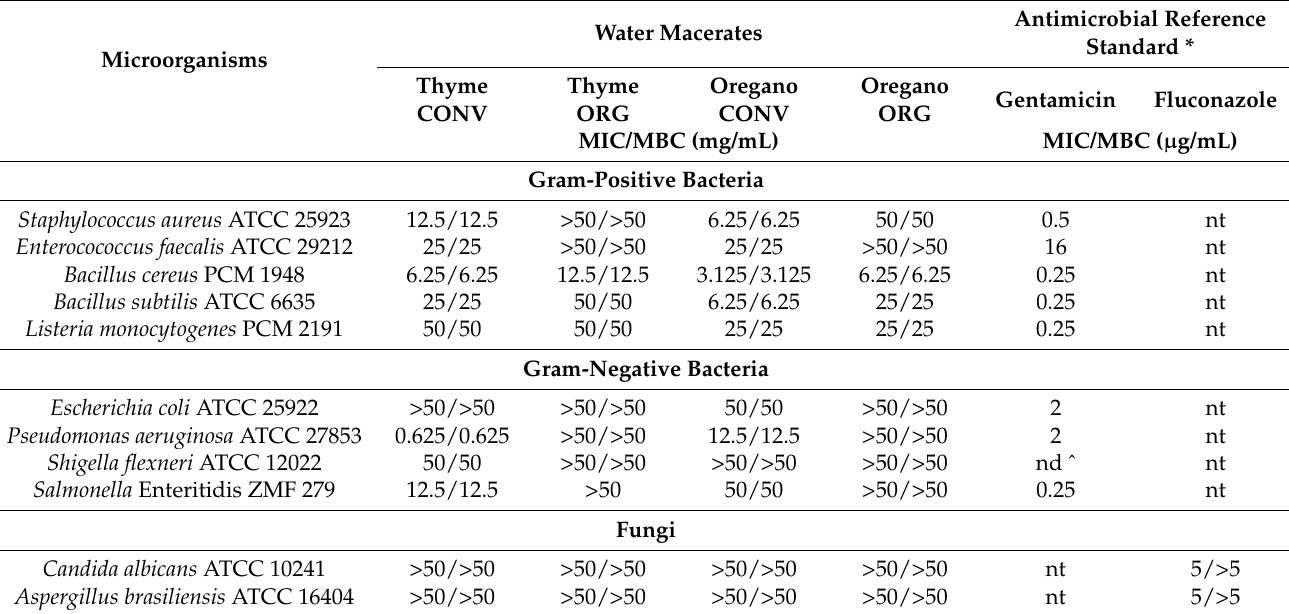
Table 2. Determined values of MIC and MBC for tested water macerates in relation to standard microorganisms. Microorganisms